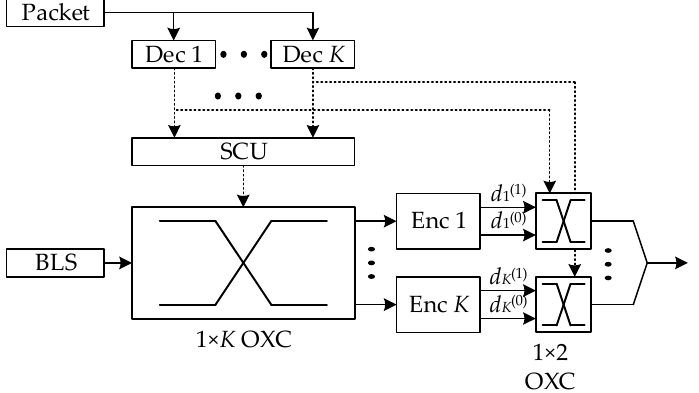
Figure 3. OCDMA buffer architecture with code conversion and TCK. BLS: broadband light source; Enc: encoder; Dec: decoder; EOM: electrical-to-optical modulator; SCU: switch control unit.